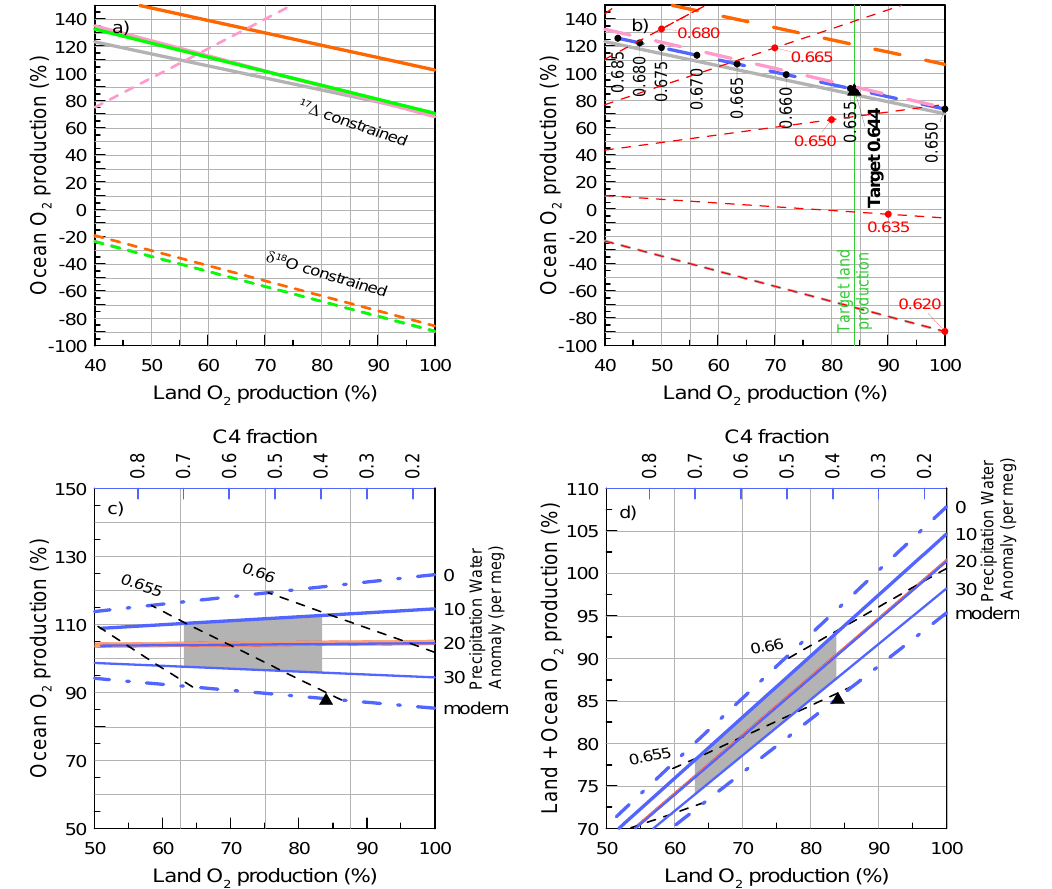
Fig. A5 Similar to Fig. 3 in the main text. Plots of ocean O 2 production vs. land O 2 production (a–c) and total O 2 production vs. land O 2 production (d) for the Last Glacial Maximum default scenario (see Table 4). The lines and areas indicate allowable values as constrained by the δ 18 O and 17 1 of paleo-atmospheric O 2 relative to the modern (100%) production. (a) Gray dashed and solid line: solutions that satisfy δ 18 O atm and 17 1 , respectively, assuming modern humidity and a hydrological anomaly similar to modern. For a 17 1 ocean water vs. atmosphere of 223 per meg and a 4.0‰ δ 18 O marine photosynthetic enrichment (lambda 0.524) with respect to seawater in the surface ocean. The orange lines are calculated for identical conditions but with a 20% increased stratospheric flux. Pink lines are for a 17 1 ocean water vs. atmosphere of 223 per meg and no photosynthetic enrichment. (b) Solutions of (a) in gray. Increasing the relative humidity (black dots and associated labels; blue line for the gray scenario in (a) ) drives the intercept of 17 1 and δ 18 O towards the target value for land productivity (see text for details). The light dashed red lines give solutions for δ 18 O with increasing relative humidity (for the gray scenario in (a) ). The 17 1 line is hardly affected by variable relative humidity. (c) and (d) Again, for a 17 1 ocean water vs. atmosphere of 223 per meg and a 4.0‰ δ 18 O marine photosynthetic enrichment (lambda 0.524) with respect to seawater in the surface ocean, the value for land carbon productivity is locked. Therefore, the land O 2 production is inversely proportional to the C4 contribution (top axis). We show solutions for precipitation anomalies from 0 to 40 per meg and soil temperature 5 ◦ C lower than modern. The lines in red represents solutions with soil temperatures 4–7 ◦ C lower than modern and a precipitation 17 1 anomaly of 20 per meg lower than modern. Black dashed lines show isolines of global GPP-weighted humidity. The gray area represents solutions we favor. Black triangles show the target value of (b)